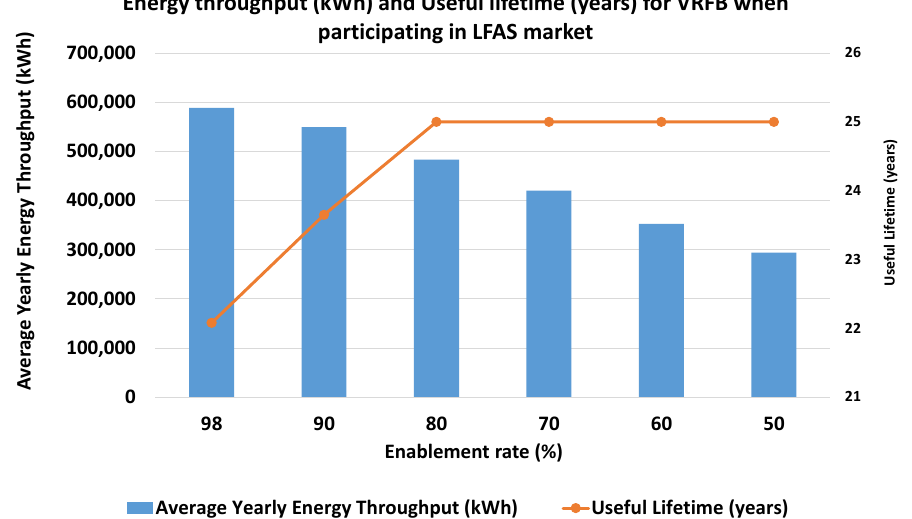
Figure 6. The energy throughput and useful lifetime of VRFB at different levels of enablement rate (%) for the LFAS market.